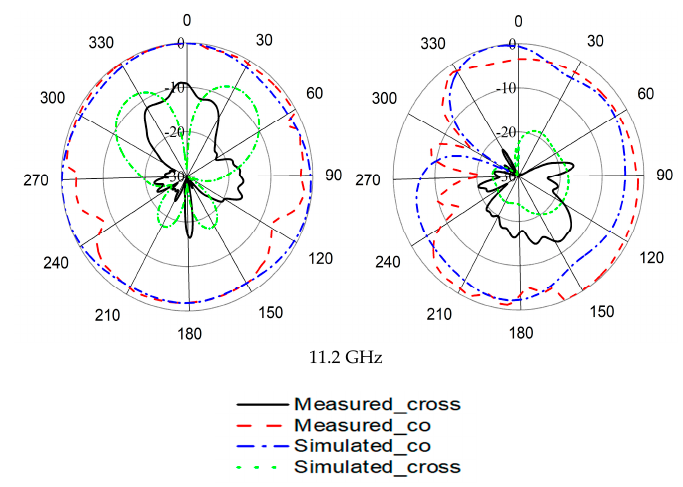
Figure 14. Simulated and measured radiation patterns of the proposed UWB antenna.